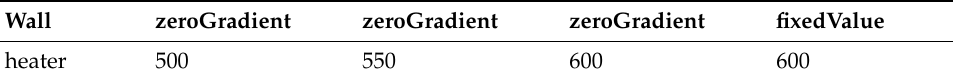
Figure 16. Model—room for CFD simulation. Table 8. Boundary